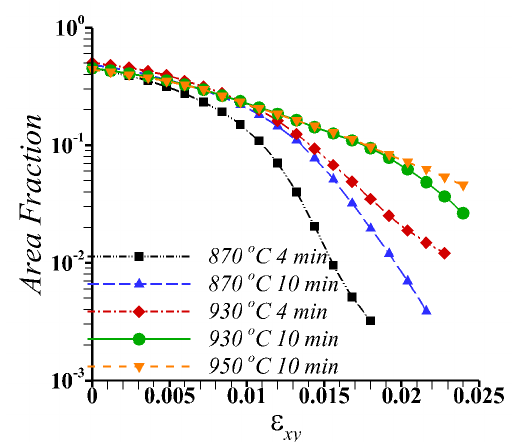
Figure 13. Variation in the area fraction of various levels of shear strain, ε xy , in 135-by-135 µ m 2 region close to the notch in the single-edge notch specimens of the five heat-treated martensitic steel deformed to a macroscopic normalized extension, δ / L 0 , of 0.05 ±